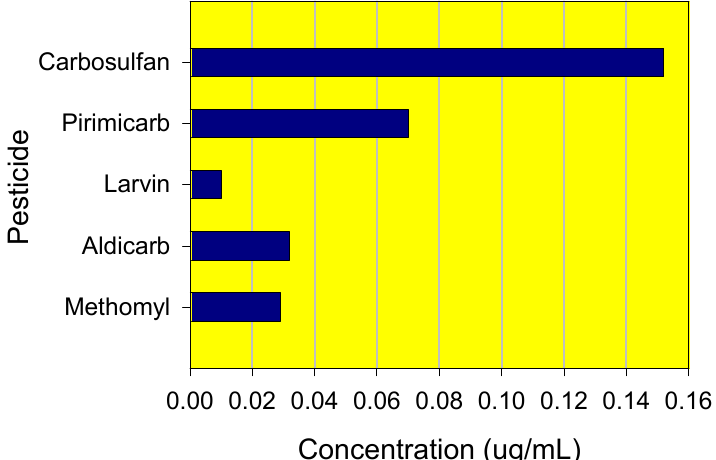
Figure 2. Maximum concentrations of pesticide residues detected in groundwater.